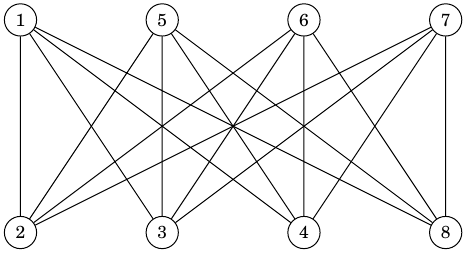
Figure 4: A productive labeling of K 4 , 4 .